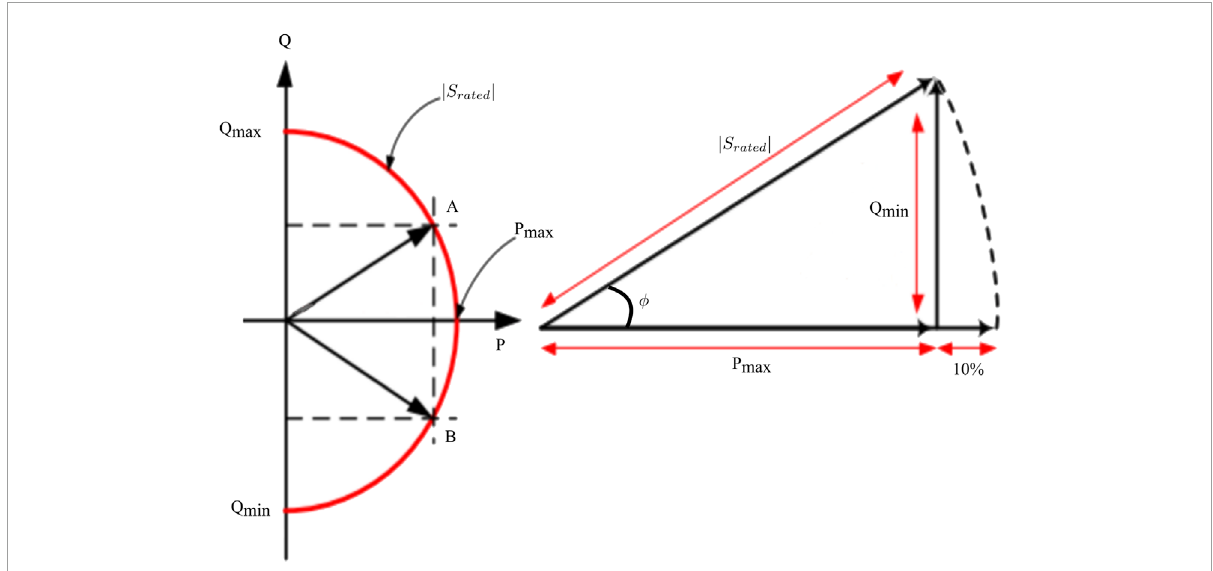
FIGURE 2 Power capability curve of smart converter (Kabiri et al., 2014).